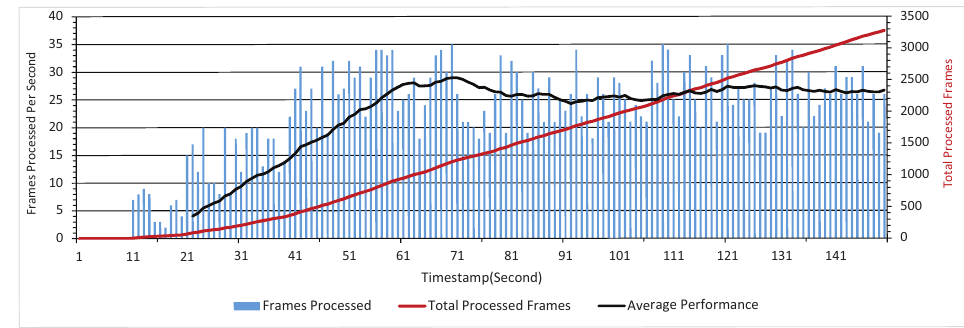
Figure 8. Maximum process capability test.